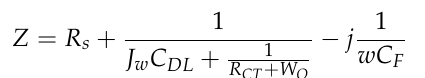
Warburg coefficient, w is the angular frequency, and n is an exponent